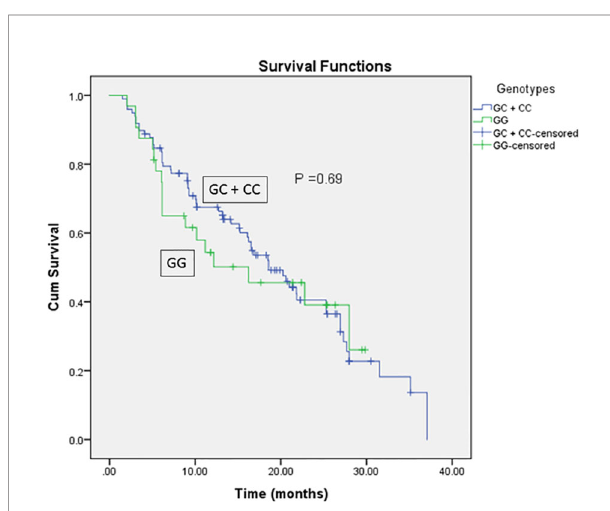
FIGURE 2 | Kaplan-Meier and Log-rank survival curves for HCC patients in relation to EpCAM rs62139665 genotypes in a recessive